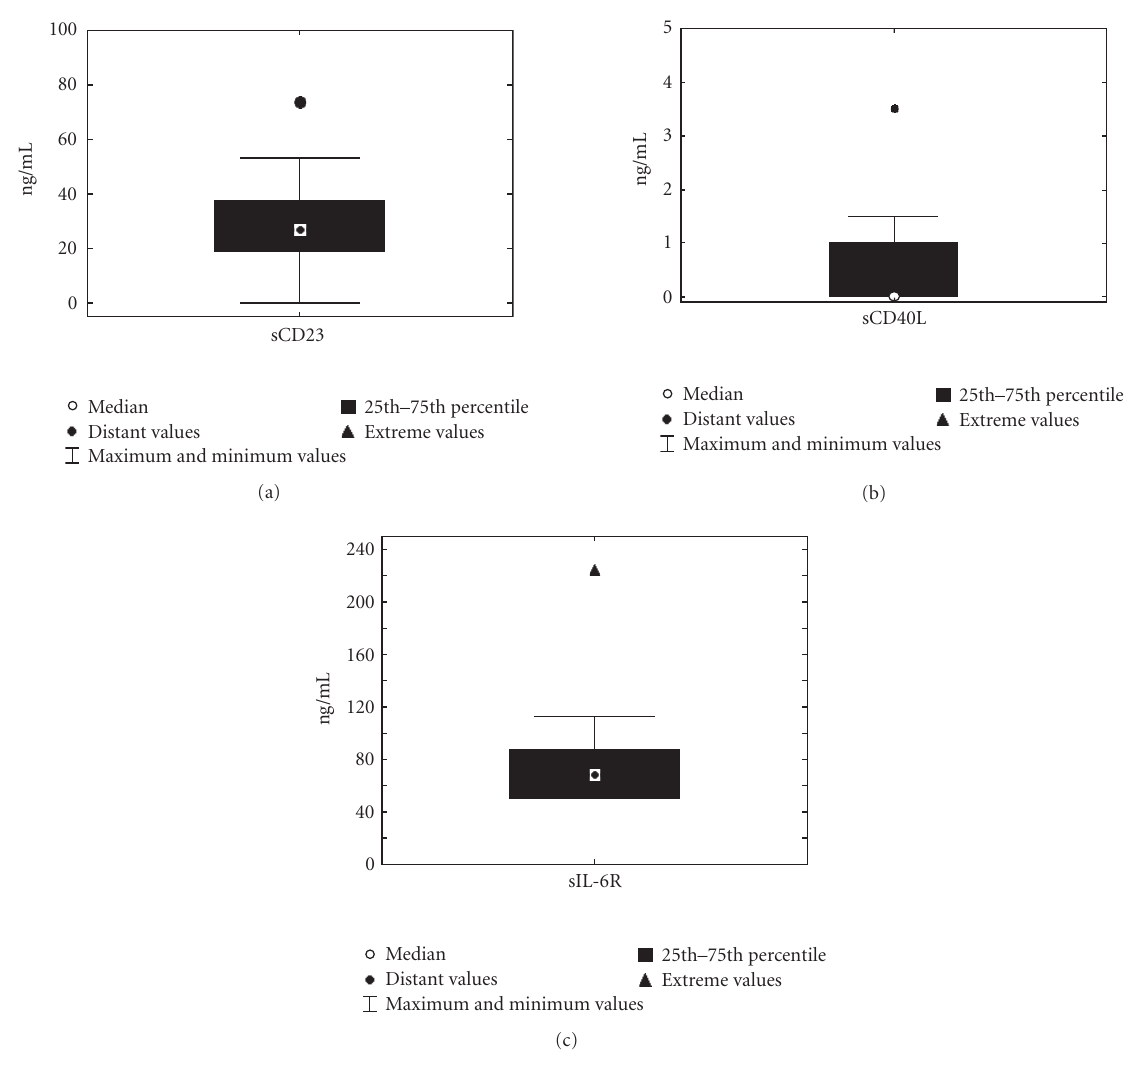
Figure 3: Plasma concentration of soluble CD23, sCD40L, and sIL-6R in the healthy blood donors (box-and-whiskers plot). See the caption in Figure